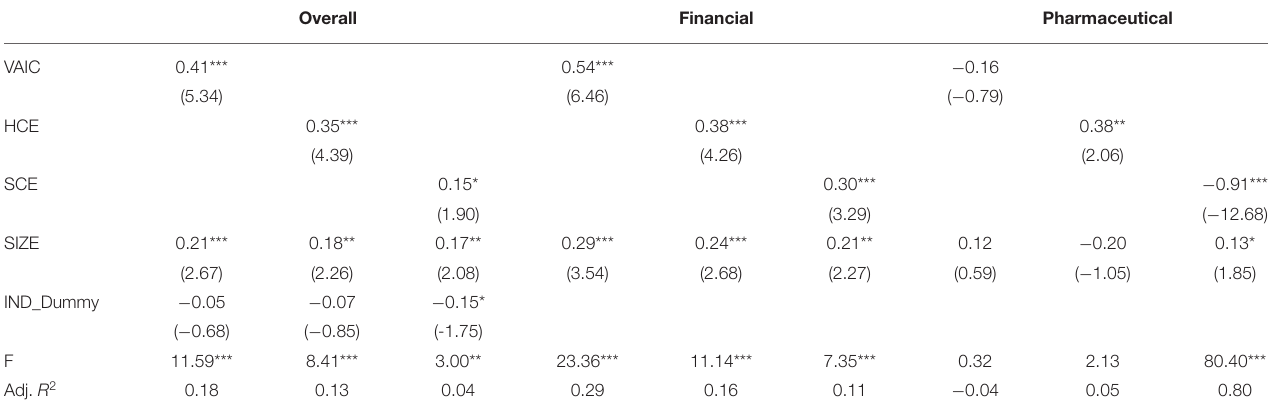
TABLE 4 | Multiple regressions of ROE on VAIC and its